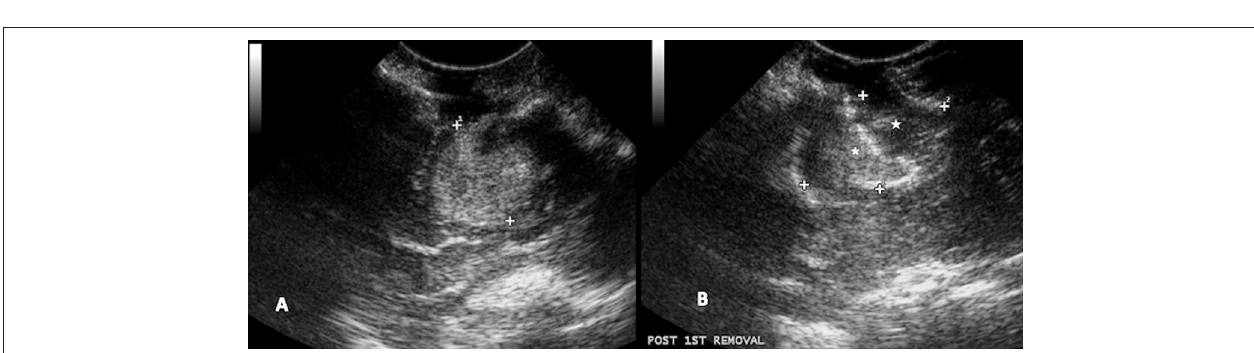
FIGURE 11 | Case 24. (A) Intraoperative ultrasound appearance of high-grade glioma before removal and (B) following partial removal. In B, the intraoperative ultrasound clearly shows the portion of the tumor removed (star) and the remaining tumor (asterisk).